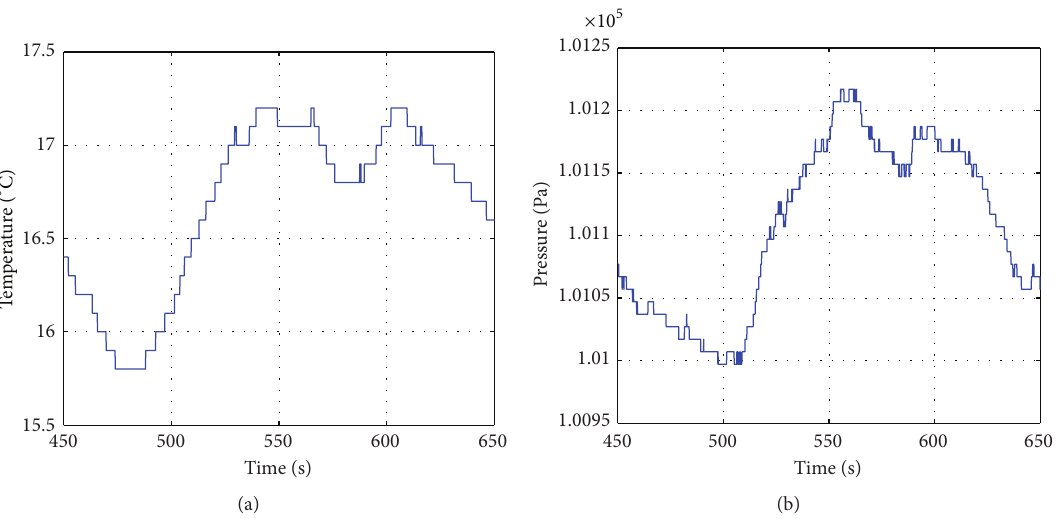
Figure 18: Environmental online data measurements via GSM channels.